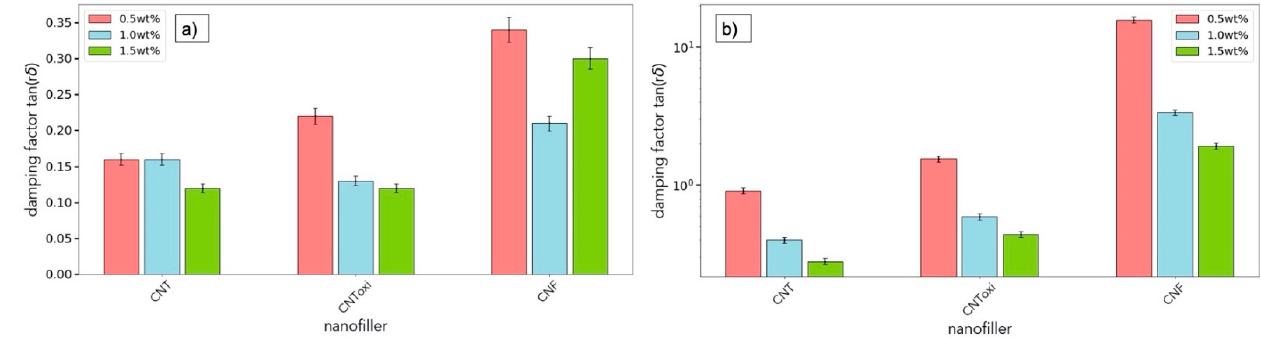
Figure 9. Damping factor shown for both dispersion methods and all filler and filler grades. ( a ) US dispersion ( b ) TRM dispersion. Note: the TRM dispersion plot is evaluated with a logarithmic y -axis.